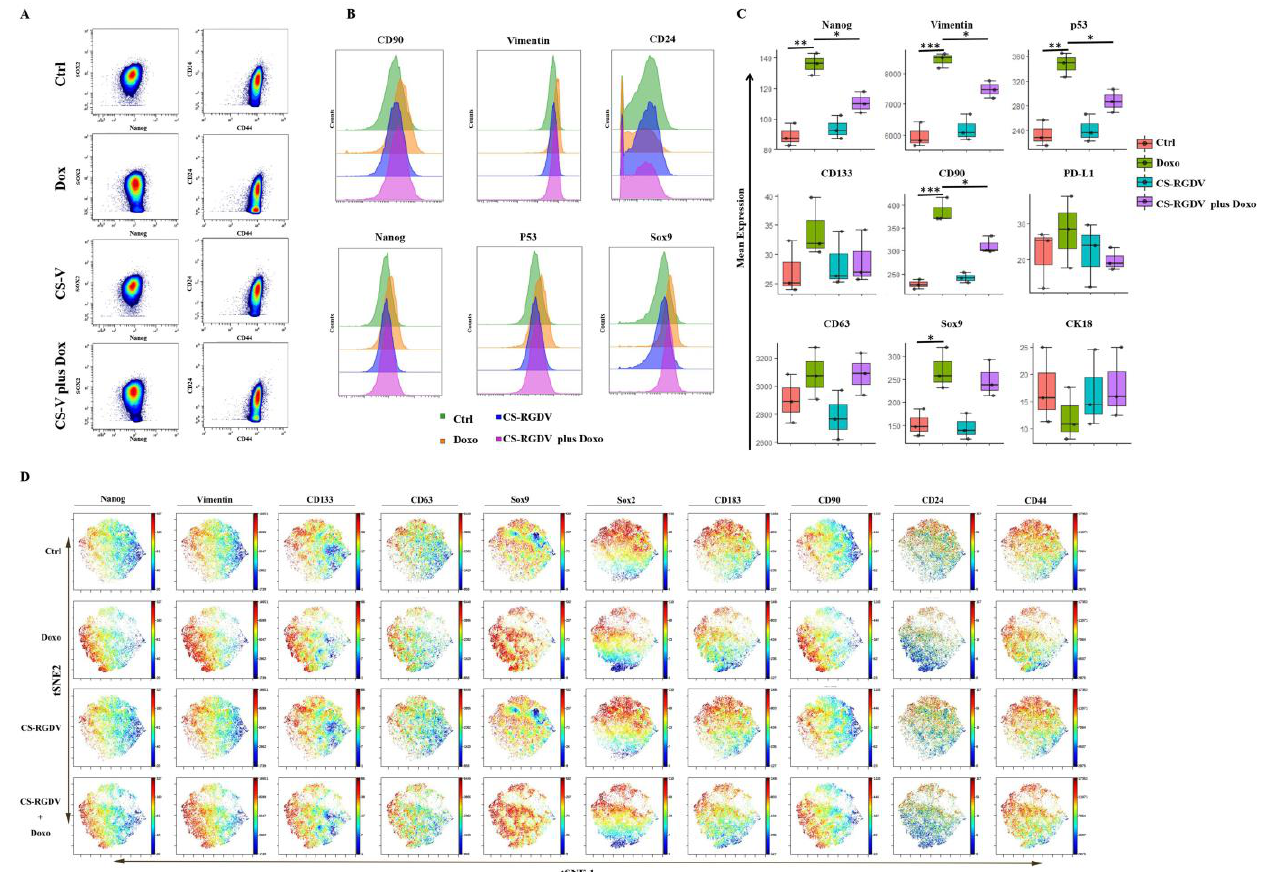
Figure 4. SPADE analysis (green-to-red scale, red represented high expression) showed stemness induced by doxorubicin was decreased in combination with CS-V nanoparticles. All the nodes in the figures represent a group of cells with similar protein expression patterns, and the size of the node represents the frequency of this group of cells.